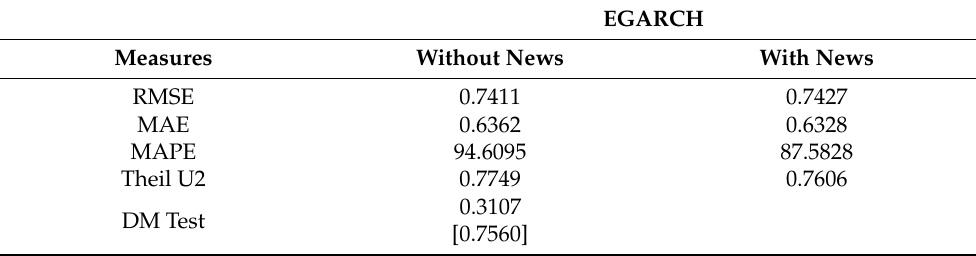
Table 6. Out-of-Sample ( 7 days) Forecast Evaluation. Value in the square bracket denotes the p -value of the DM test using the MAE loss function. The same results hold if we use the MSE as the error